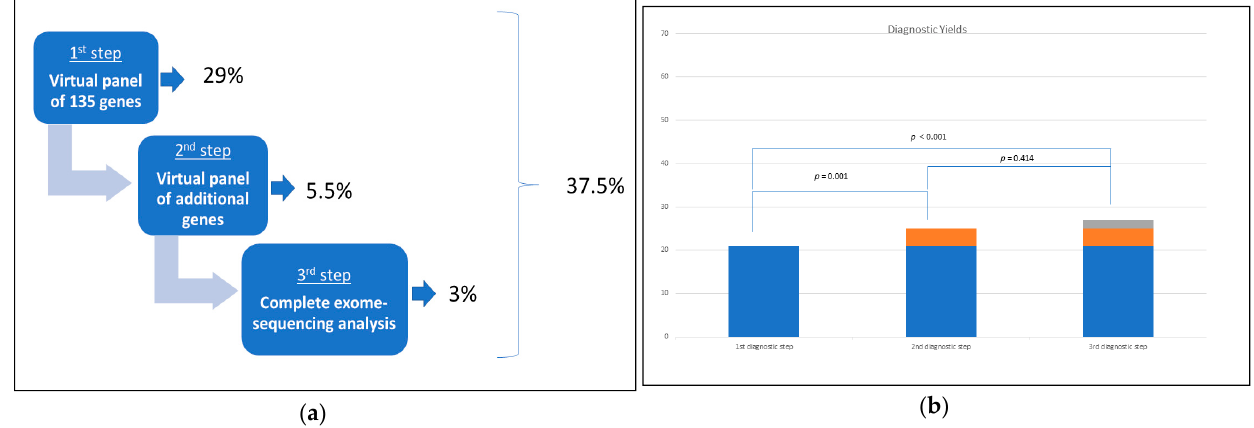
Figure 1. ( a ) Diagnostic yields increase in the three genetic-workup steps with the statistically significant difference between the three different steps. ( b ) 21 out of 72 patients (29%) obtained a genetic diagnosis at the first “virtual panel” of 135 genes. The exome-based reanalysis of additional genes more recently associated to epilepsy and NDDs and/or DEEs provided a genetic diagnosis in 4 patients (5.5%), whereas another 2 patients were genetically diagnosed exploring the complete CES/WES data (3%). Table 1. Clinical, epileptological, and genetic characteristics of probands with pathogenic or likely pathogenic variants grouped based on diagnostic level. Abbreviations: ASD, autism spectrum disorder; DEE, developmental and epileptic encephalopathy; DS, Dravet Syndrome; LGS, Lennox-Gastaut Syndrome; LKS, Landau-Kleffner Syndrome; F, female; ID, intellectual disability; M, male; m, months; NDD, neurodevelopmental disorder; Y, years.